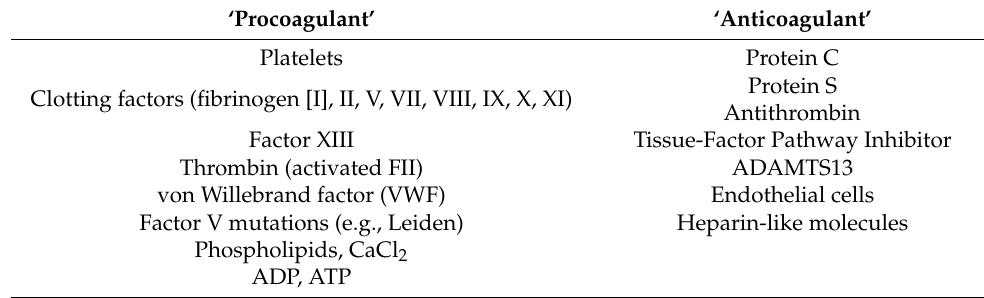
Table 1. Some key procoagulant and anticoagulant components of hemostasis.